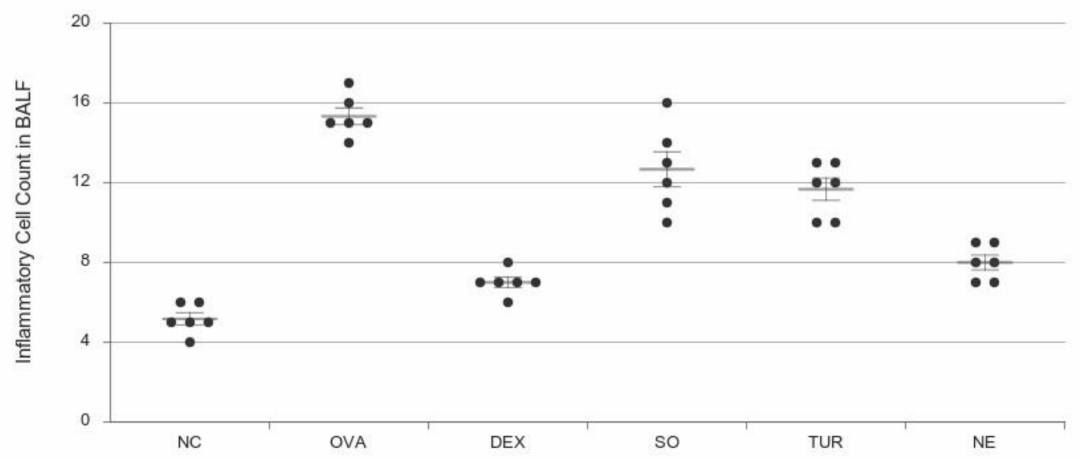
Figure 5. E ff ect of oral administration of dexamethasone (DEX), vehicle SO, turmeric (TUR), and nano-emulsion on inflammatory cells count in the bronchoalveolar lavage fluid (BALF) of OVA-sensitized mice (i.p. day 1st and 10th) and challenged with OVA (inhalation, from day 19th to 24th). The normal control (NC) received normal saline. The results were expressed as Mean ± SEM ( n = 6) in cell count × 10 6 / mL BALF. One-way ANOVA was followed by the Student–Newman–Keuls test. DEX and NE have p < 0.001, TER has p < 0.01, SO has p < 0.05 compared with disease control (OVA), and OVA has p < 0.001 compared with